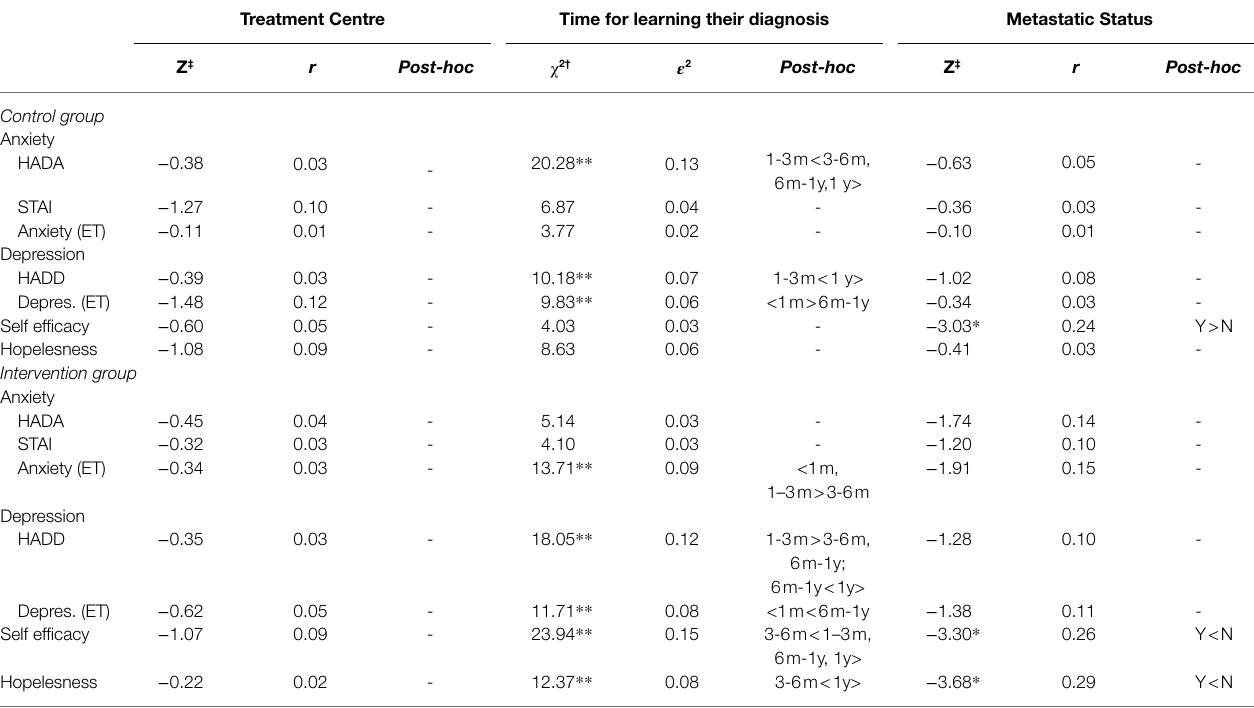
TABLE 6 | The impact of demographic variables “b” on anxiety and depression scores, self-efficacy, and hopefulness. Treatment Centre Time for learning their